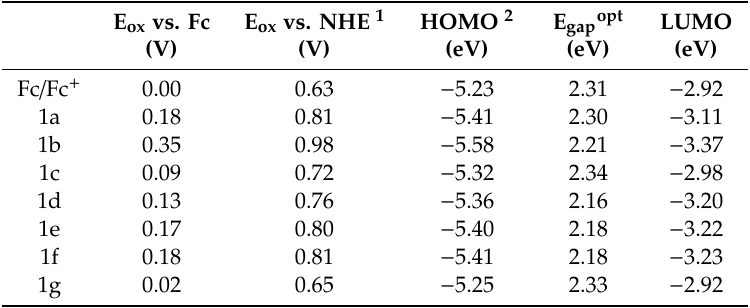
Table 2. Electrochemical properties of Fc-based derivatives 1a–1g (CH 3 CN).